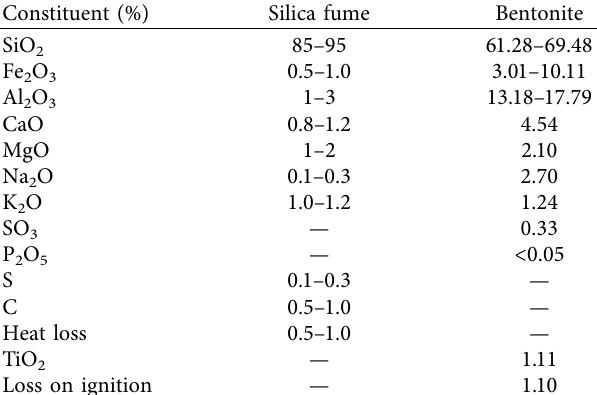
Table 1: Te chemical compositions of bentonite and silica fume. Constituent (%) Silica